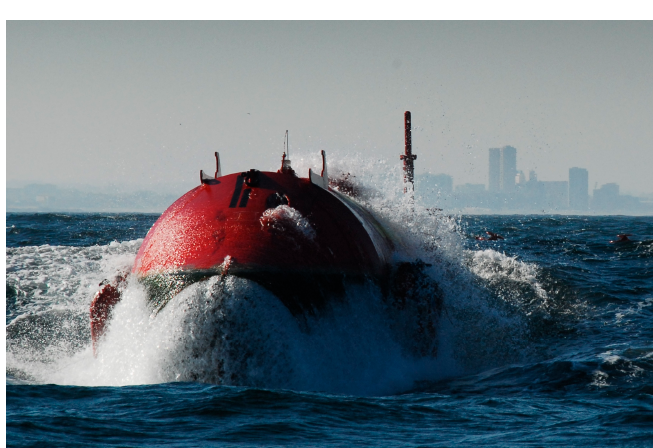
Figure 2. The Pelamis wave energy converter. (Source: Pelamis Wave Energy Converter on site at the European Marine Energy Test Center (EMEC) by P123, retrieved from https://commons.wikimedia.org/wiki/File:Pelamis_at_EMEC.jpg).